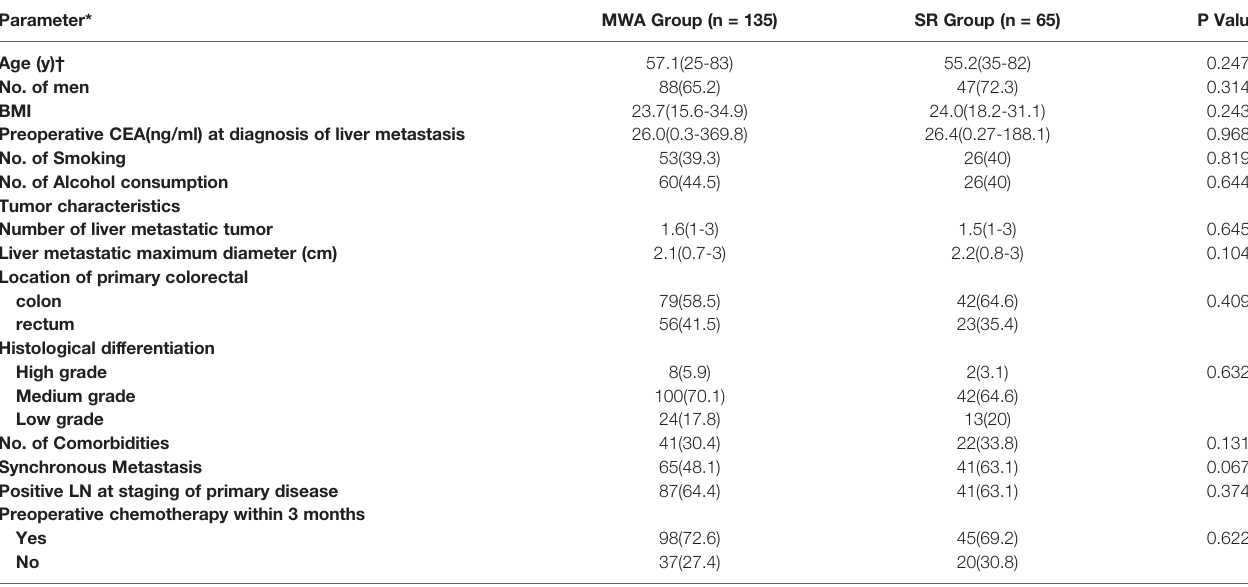
TABLE 1 | Baseline characteristics of study patients and